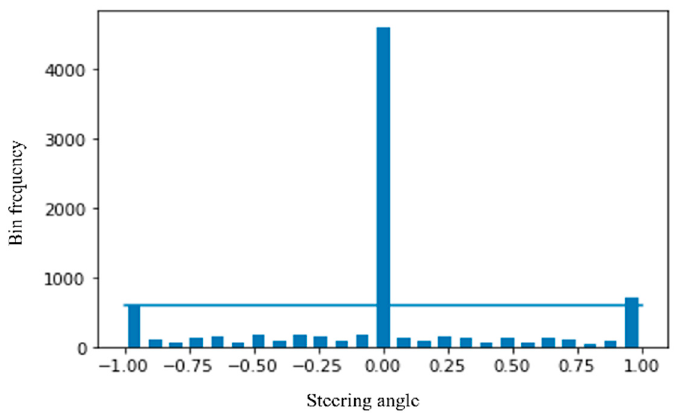
Figure 9. Visualization of the dataset.